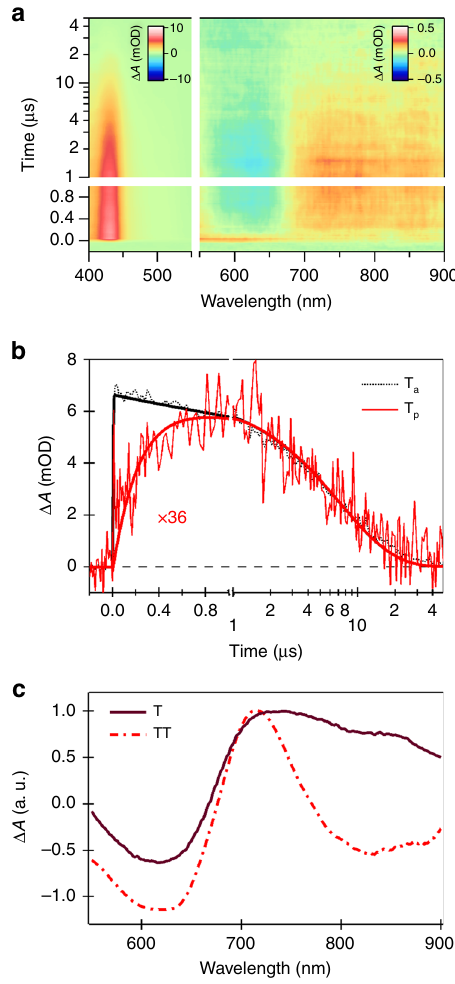
Fig. 4 Triplet sensitization experiment. a Sensitized experiment of IIDDT- Me in the diluted DCB solution. b The dynamics taken at anthracene triplet (T a ) and polymer triplet (T p ) transient absorption region. c The lineshape